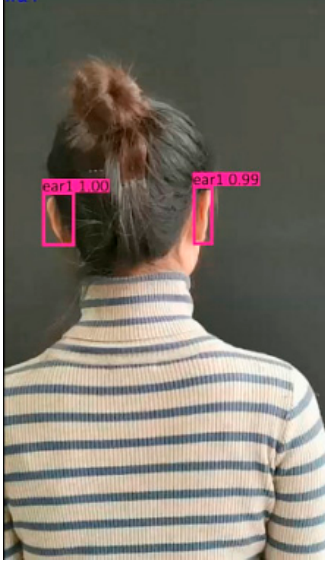
Figure 7. Video test results of ear1.